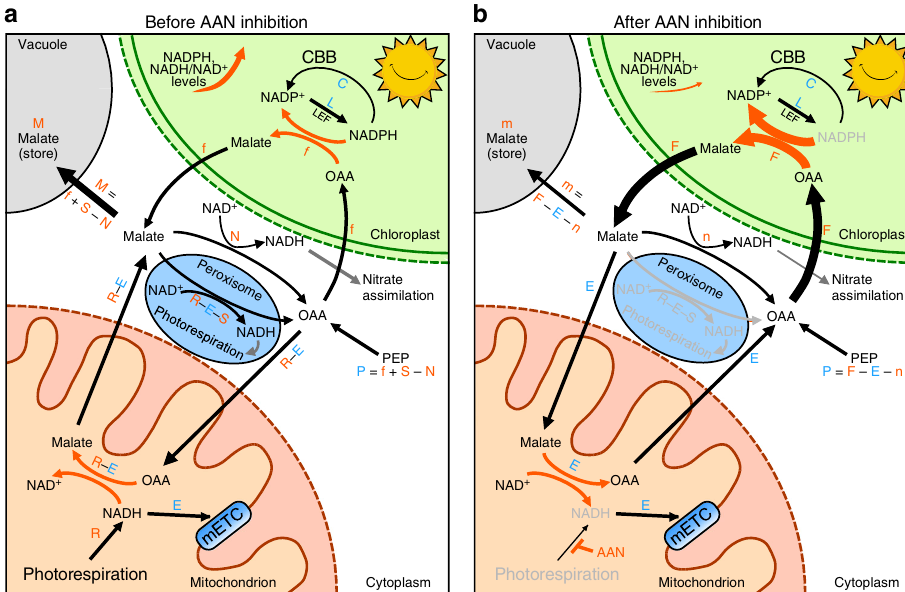
Fig. 5 Working model of the fl ow of malate between several subcellular compartments of photosynthetic C3 plant cells. a Malate fl ow when photorespiration is present. b Malate fl ow when photorespiration is inhibited by AAN or NaHCO 3 . Chloroplast, mitochondrion, and peroxisome are represented by green, brown, and blue circles, respectively. L represents the rate of NADPH production by the LEF and C represents the rate of NADPH consumed by the CBB. Letters in blue (P, C, E, and L) denote entities that are assumed to be unaffected by AAN or NaHCO 3 treatments at the initial stage of illumination. Letters in red denote entities that are assumed to be affected by AAN or NaHCO 3 treatments and values that are expected to be larger were represented by capital letters. F is increased but m and n are diminished by AAN and carbohydrates. At 296 µmol m − 2 s − 1 illumination, the cytosolic